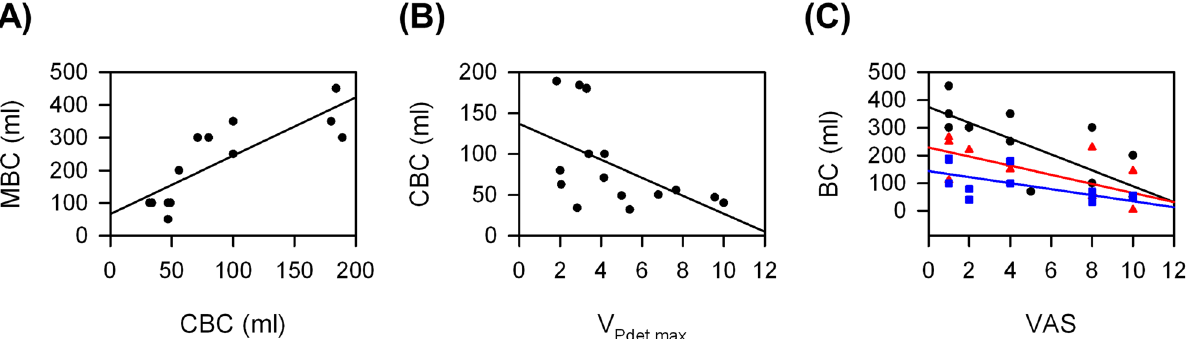
Figure 1. Significant associations between urodynamic parameters from KC patients: ( A ) between MBC and CBC, ( B ) between CBC and V Pdet.max , and ( C ) between MBC (black circle), ΔBC (red triangle), or CBC (blue square) and VAS.